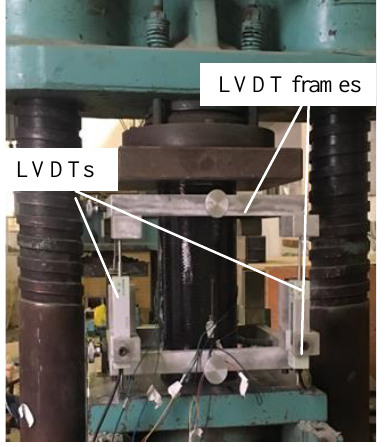
Figure 4. Test setup.